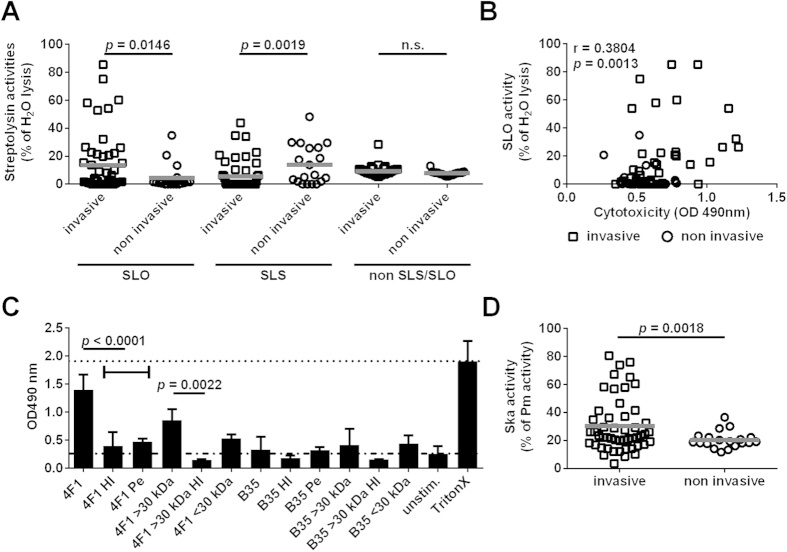
SLO-mediated cytotoxicity towards human keratinocytes.(A) Streptolysin activities in bacterial supernatants derived from stationary growth phase. Each dot represents the mean value of three independent experiments with one strain. The horizontal lines within each group represent the mean value. The statistical significance between the two groups was determined using two-tailed Mann-Whitney U-test. (B) Correlation analysis of SLO hemolytic activity and keratinocyte cytotoxic activity in bacterial supernatants. Correlation was determined using Pearson test. (C) Cytotoxicity induced by different fractions of bacterial supernatants from 4F1 and B35 strains (HI, heat inactivation; Pe, pepsin treatment). The data represent the mean values ± SD (n ≥ 3). The statistical significance between the two groups was determined using two-tailed Mann-Whitney U-test. (D) Streptokinase activities in bacterial supernatants derived from stationary growth phase. Each dot represents the mean value of three independent experiments with one strain. The horizontal lines within each group represent the mean value. The statistical significance between the two groups was determined using two-tailed Mann-Whitney U-test.